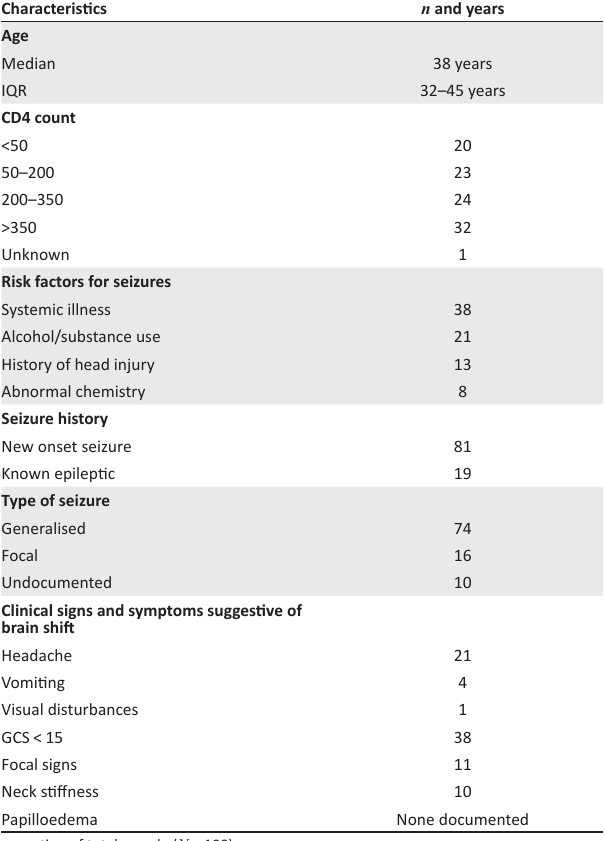
TABLE 1: Baseline characteristics of patients. Characteristics